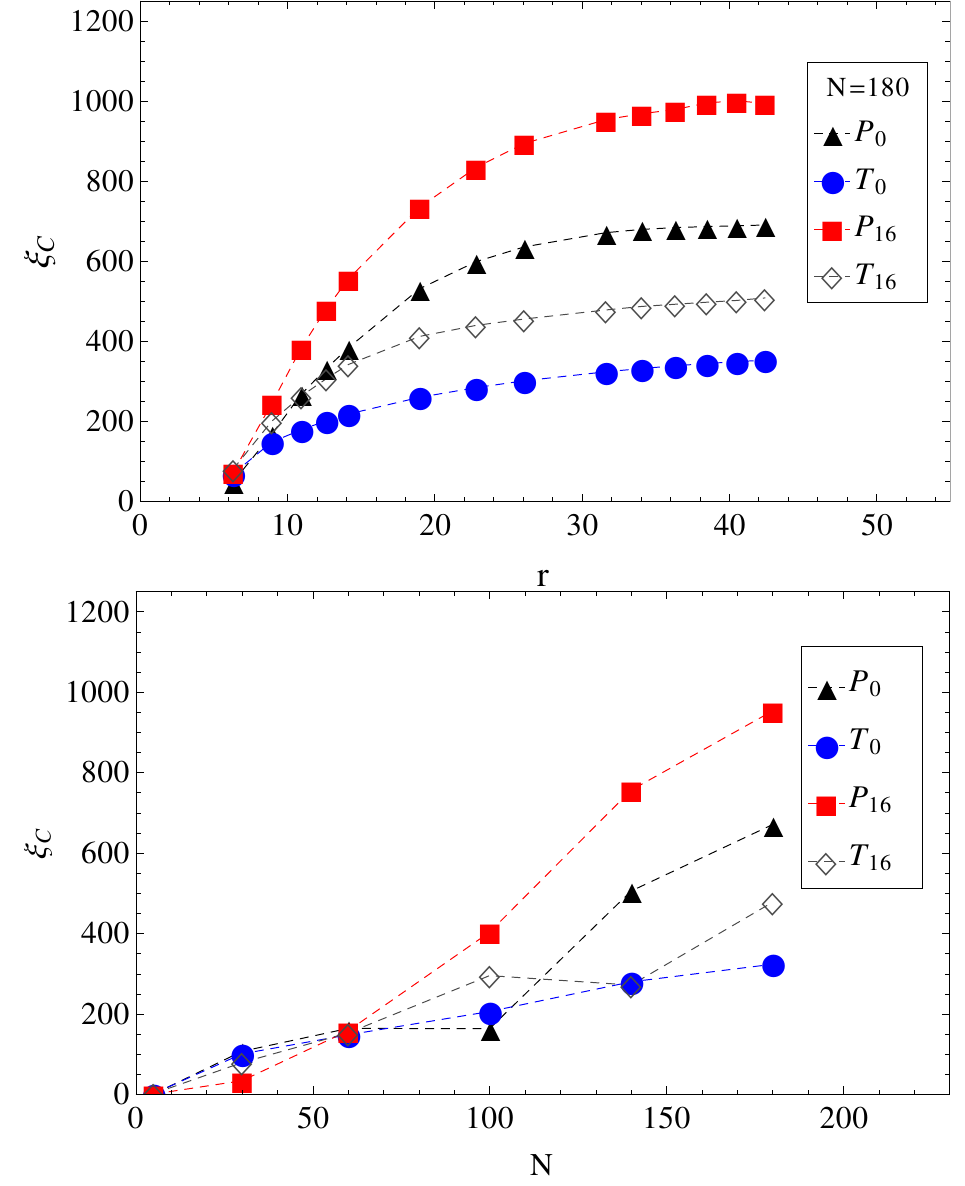
Figure 4. (Top) Electrolyte friction ξ as a function of distance r from the polyelectrolyte C ( N = 180 ) for limiting cases of smooth and, respectively, wavy surfaces, in parallel (geometries P , P ) and in parallel with perpendicular applied fields (geometries T 0 16 (Bottom) Plateau values (large r ) of electrolyte friction ξ as a function of chain length N C for the same geometries, P , T , P and T 0 0 16 16